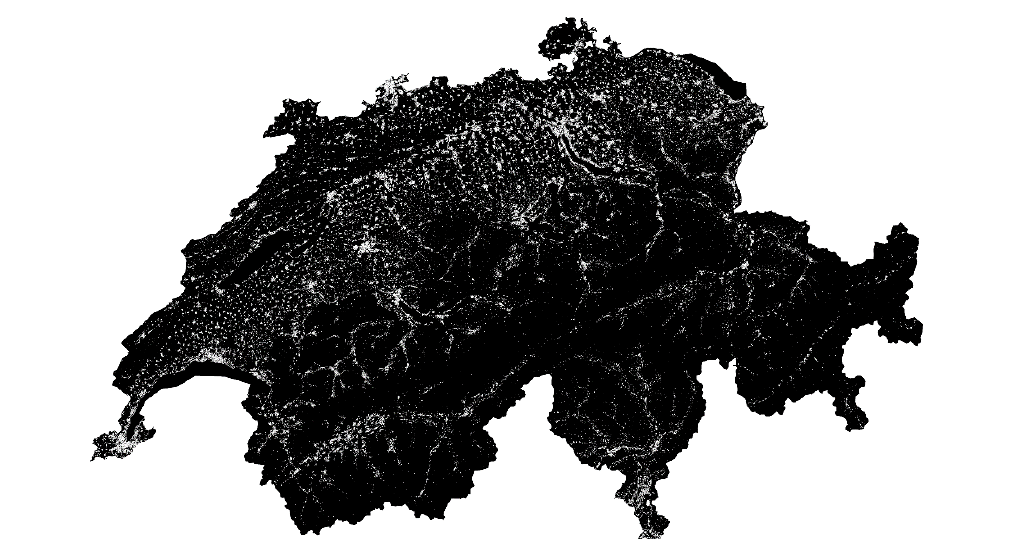
Figure 1. Urban Switzerland in 2014: built (white). Source: Horizontal Metropolis, a radical project , Venice Architecture Biennale 2016,